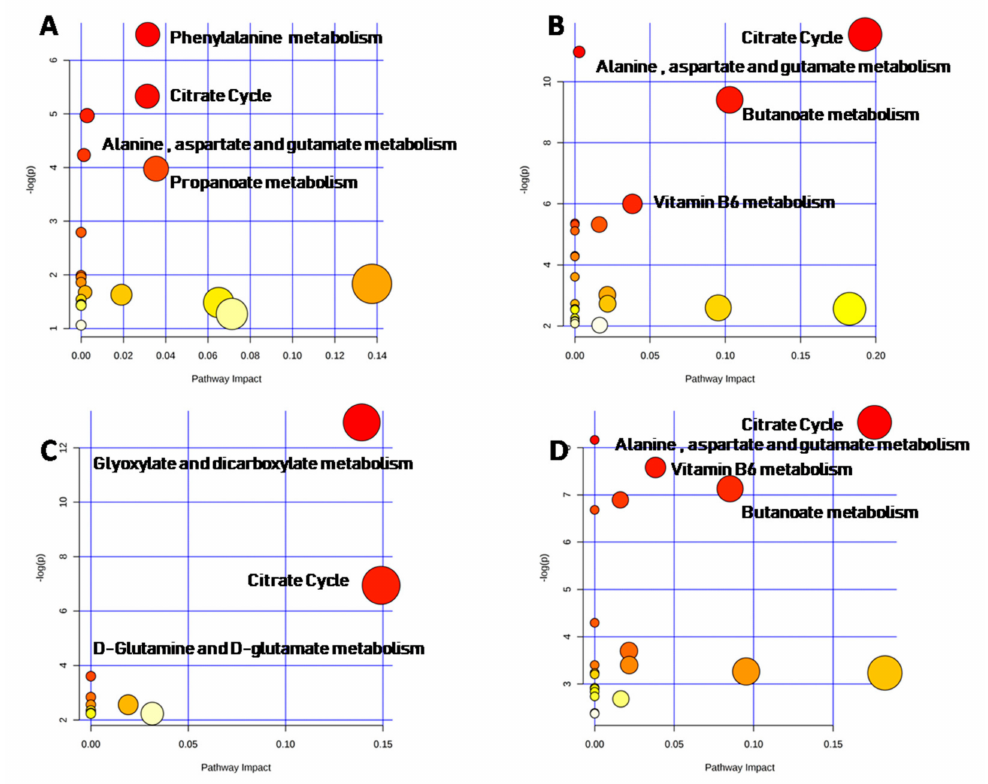
Figure 7. Metabolic pathway analysis for age. Pathway analysis plots were developed as function of the age of the subjects: age group 1( A ), age group 2 ( B ), age group 3 ( C ), age group 4 ( D